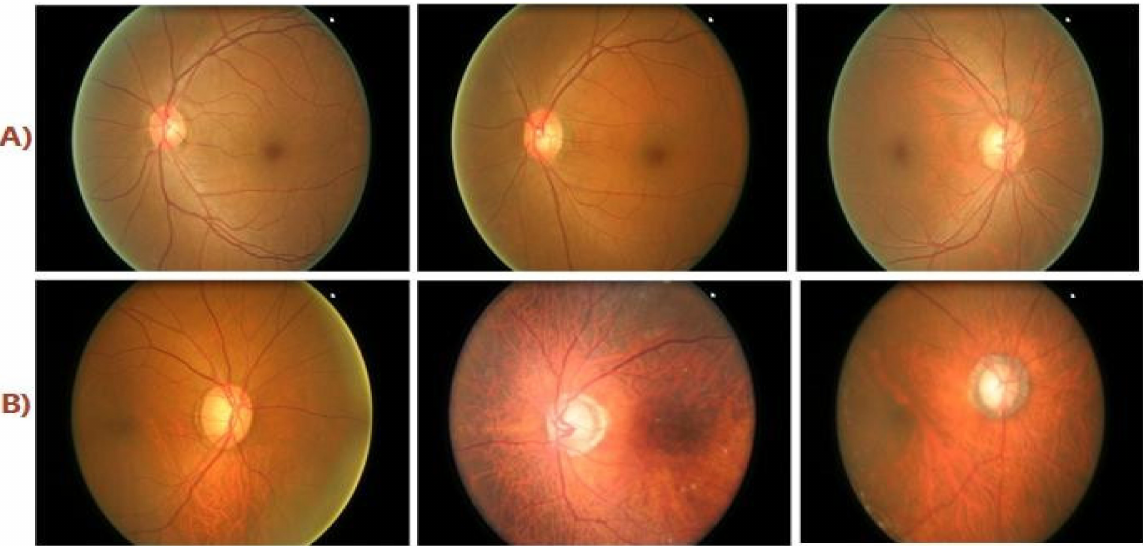
Figure 1. ( A ) Healthy Class Fundus Images; ( B ) Diseased Class Fundus Images.